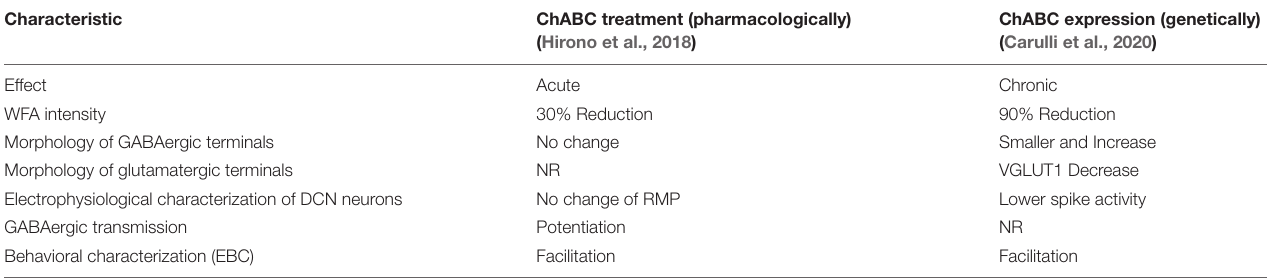
FIGURE 3 | Perineuronal net-expressing in the deep cerebellar nuclei and schematic diagram of a GABAergic presynaptic terminal. (A) Perineuronal nets, which are labeled by Wisteria floribunda agglutinin (green), are expressed in the deep cerebellar nuclei: interpositus (Int), lateral (Lat) and medial (Med) nucleus of a mouse coronal section (upper panel). Schematic view of the three nuclei in the mouse cerebellar coronal section (lower panel). (B) A chondroitin sulfate proteoglycan (CSPG) binds to receptor-type protein tyrosine phosphatase (RPTP) via the chondroitin sulfate binding N-terminal of the RPTP. The intracellular domains of the RPTP may alter the release of GABA by directly controlling the release machinery or the intracellular Ca 2 + concentration through changes of the phosphatase activity, or by interacting with Slitrk3, p250GAP, and liprin- α (Südhof, 2012). The CSPG may also regulate the expression of presynaptic GABA B receptors (Dzyubenko et al., 2020). (A) is our unpublished data. TABLE 2 | Comparisons of phenotypes in the mouse DCN treated with